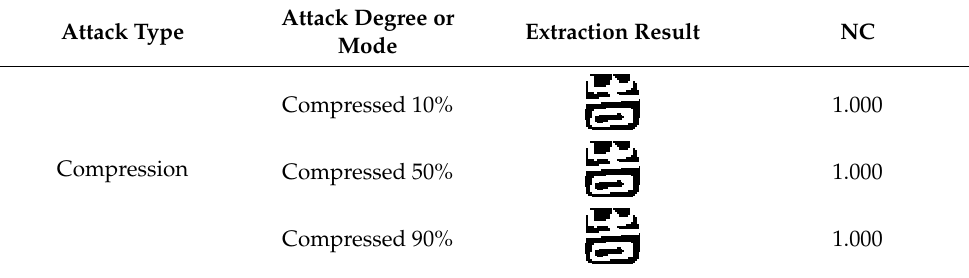
Table 4. Watermark extraction results under compression attacks.